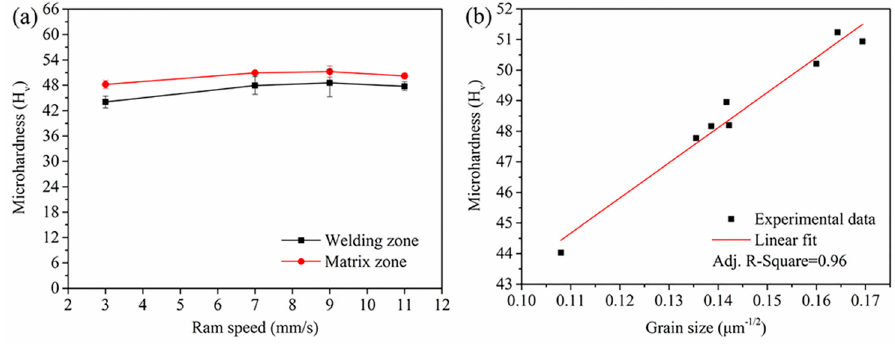
Figure 13. Microhardness of profile as a function of ( a ) ram speed, ( b ) average grain